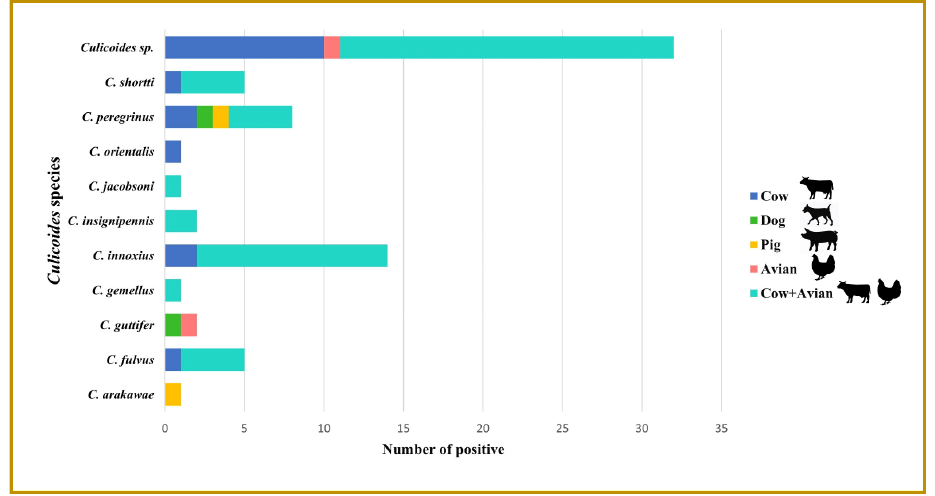
Figure 4. The frequency of host blood meals identified in Culicoides species collected from Phatthalung Province, Southern Thailand. Note: Human blood was not detected in specimens of engorged midges.